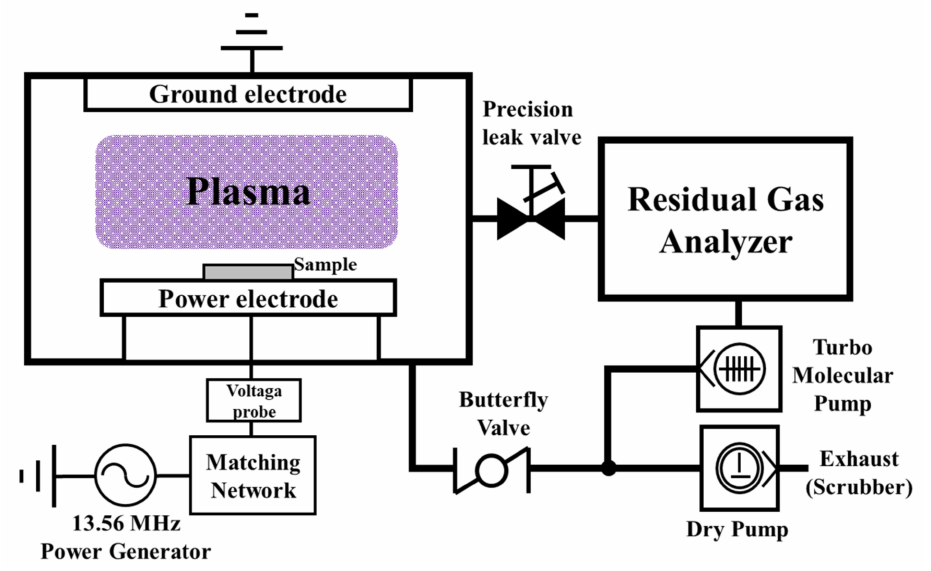
Figure 1. Plasma etching equipment